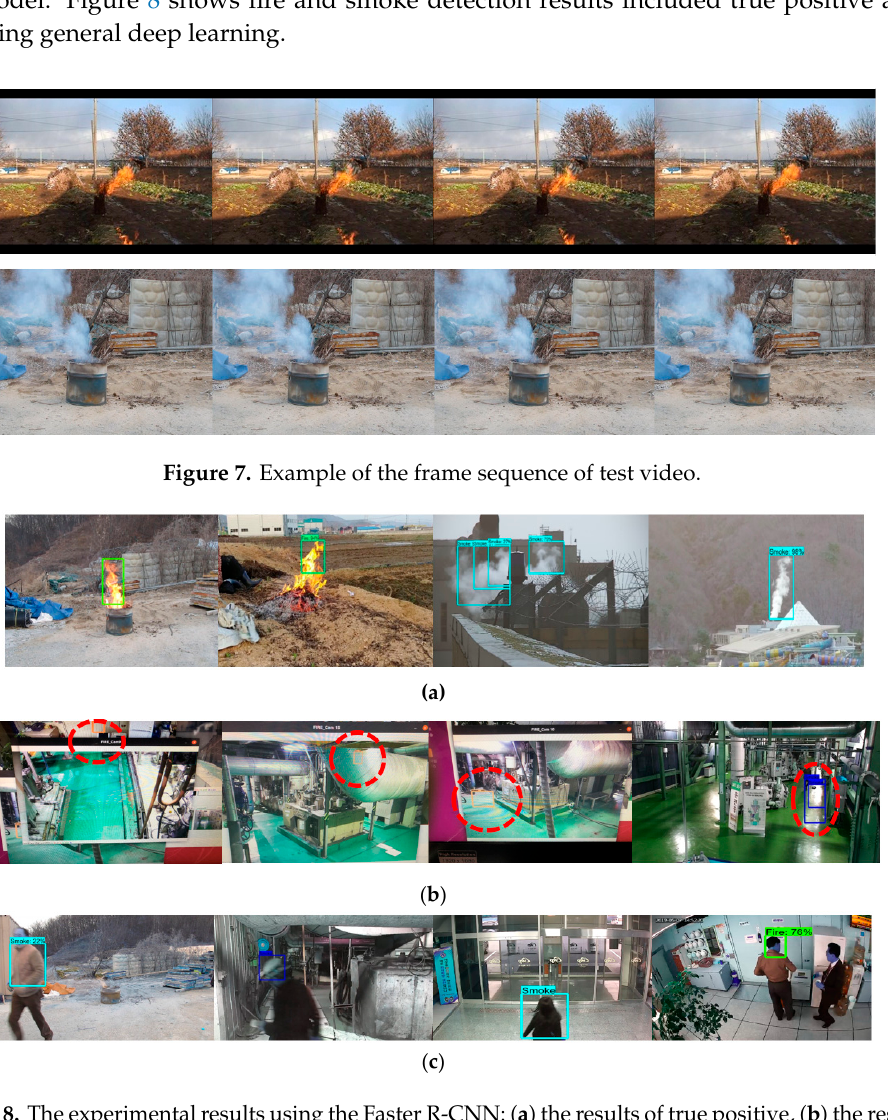
Figure 8. The experimental results using the Faster R-CNN: ( a ) the results of true positive, ( b ) the results of false positive (similar shape and color and reflection of sun and light), ( c ) the results of false positive (moving objects and similar color).